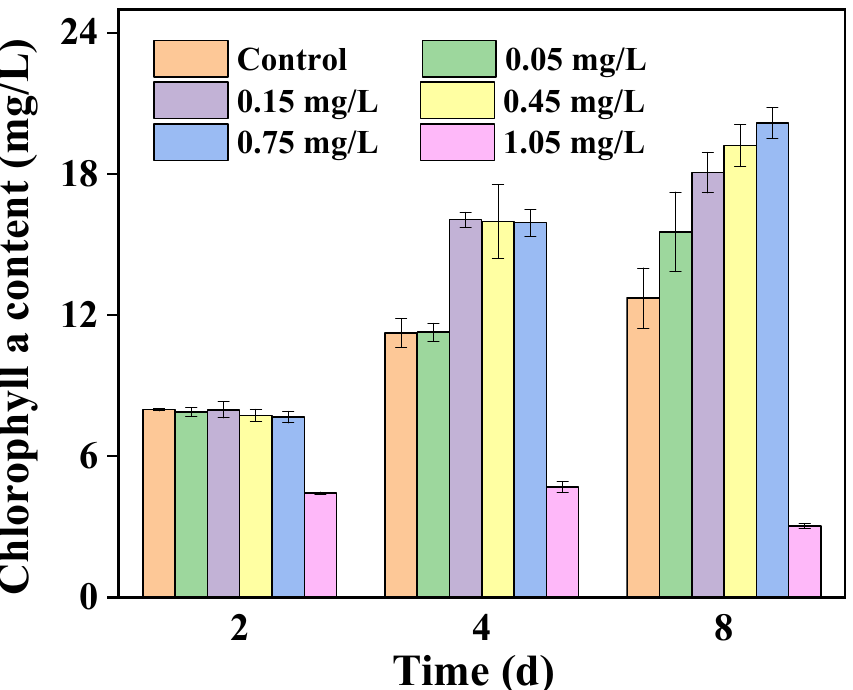
Figure 2. Effects of triclosan on the chlorophyll a content of Chlorella vulgaris .